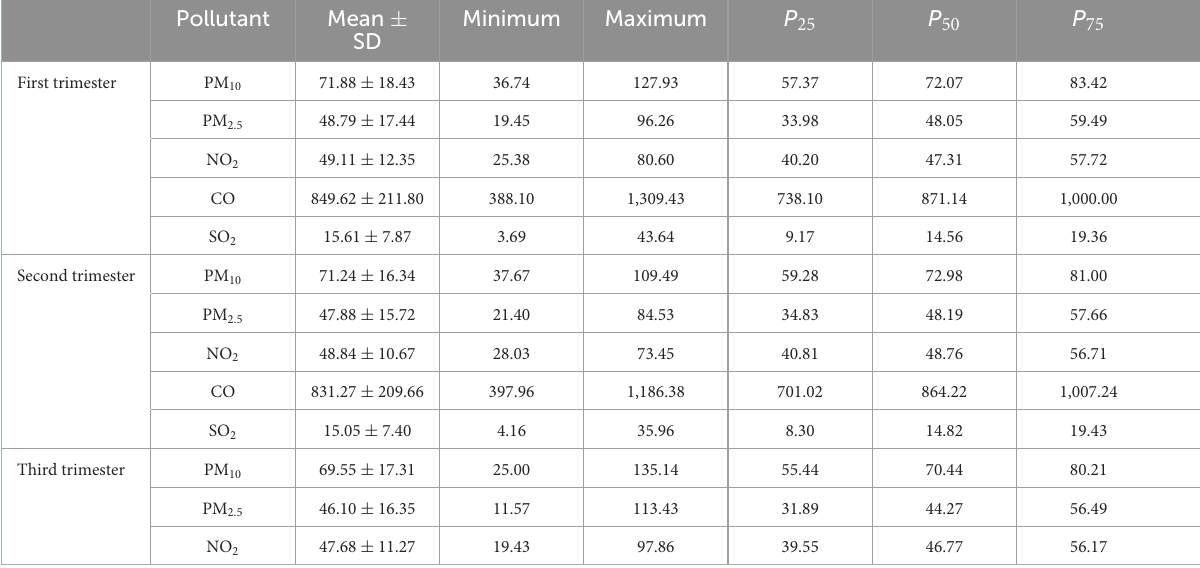
TABLE 3 Maternal exposure level of each pollutant during different gestation ( µ g/m 3 ).